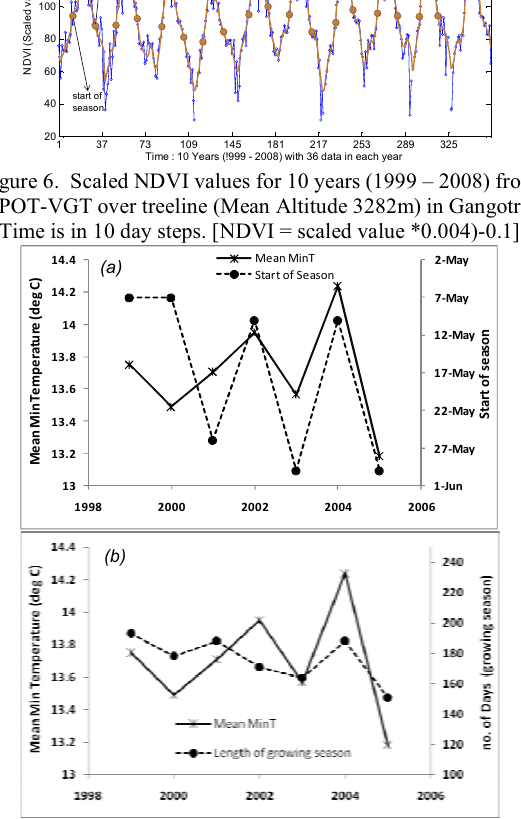
Figure 7. (a): Start of the season (from NDVI time series) Vs the Mean Min annual temp. [r 2 = -0.60]. (b): Growing season Vs Mean Min. annual temp.: [r 2 = 0.66]